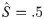
Generalized binding sites.(a) Explicit subsite interactions (dotted lines) between two binding sites, showing the “head to tail” alignment. The Hamming distance between the counter-aligned sites is 4, and so the interaction strength is S^=.5. (b) Taking the critical strength S^c=.75, these two subunits encode two interactions in the assembly graph. The interactions have different strengths (indicated by line thickness), with the upper interaction stronger (S^=.875) than the lower (S^=.75).